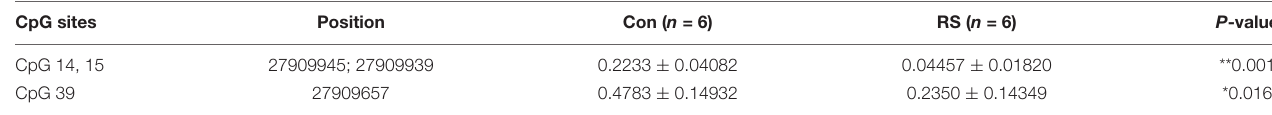
TABLE 2 | GCH1 DNA methylation values for each CpG unit in control and RS